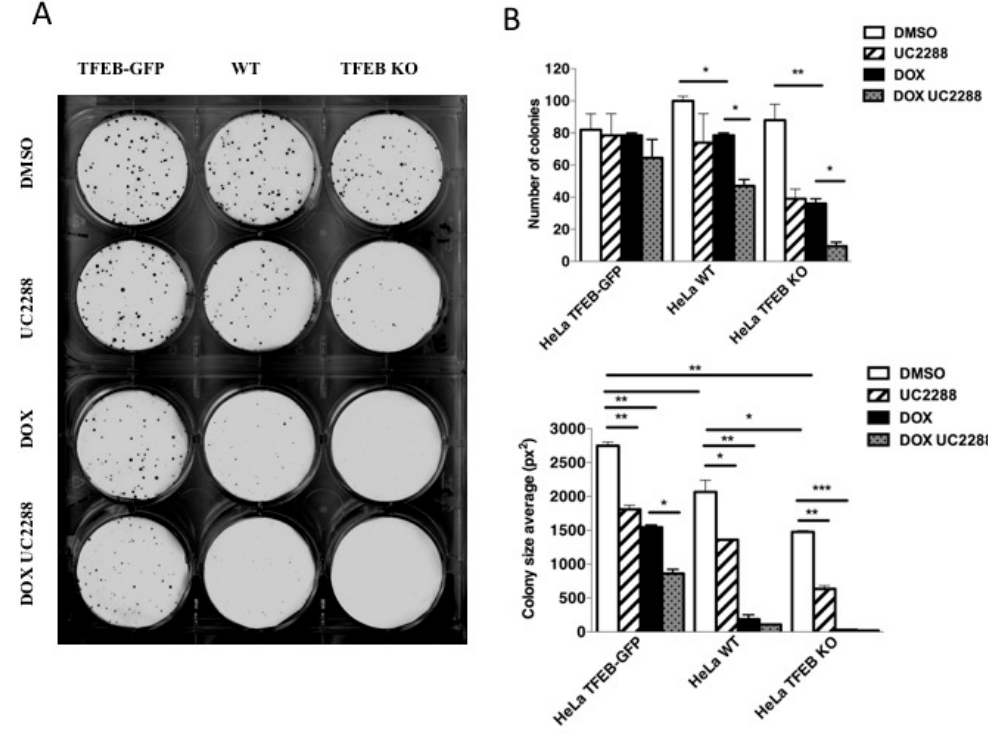
Figure 5. TFEB promotes cancer cell survival upon DNA damage through p21 upregulation. ( A ) Representative pictures of colony formation capacity in HeLa TFEB-GFP, WT, and TFEB